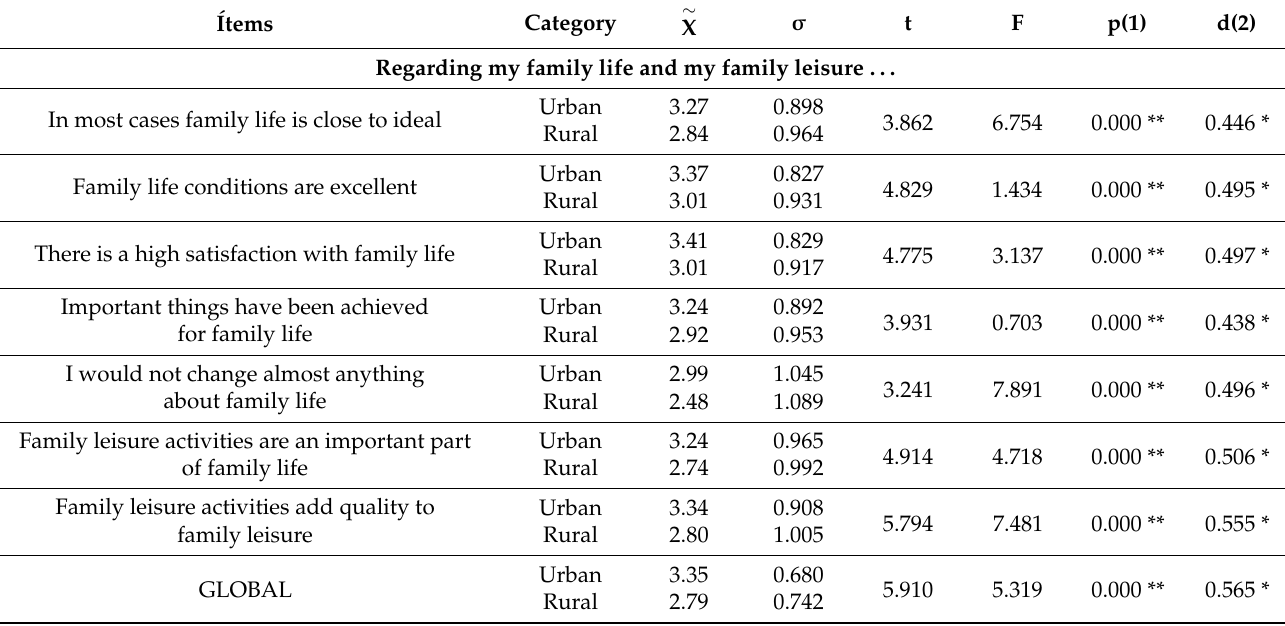
Table 6. Descriptive and inferential statistics of satisfaction with family life and family leisure as a function of